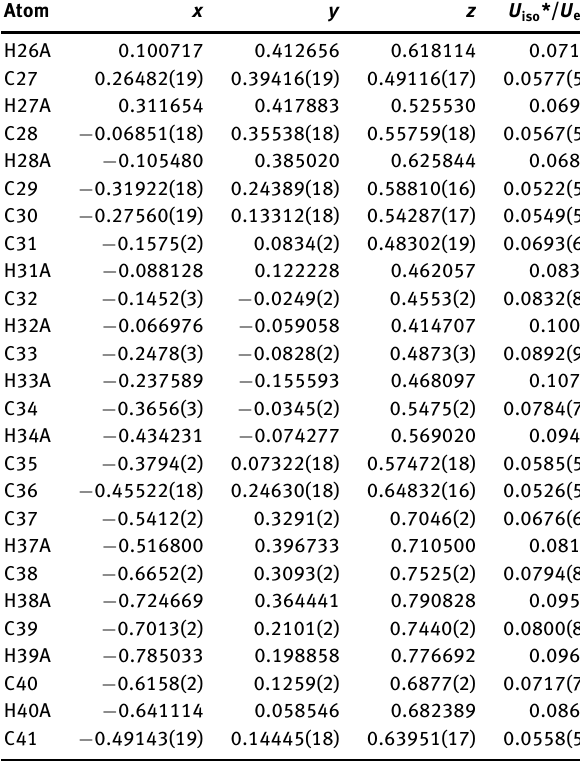
Table 2: Fractional atomic coordinates and isotropic or equivalent isotropic displacement parameters (Å 2